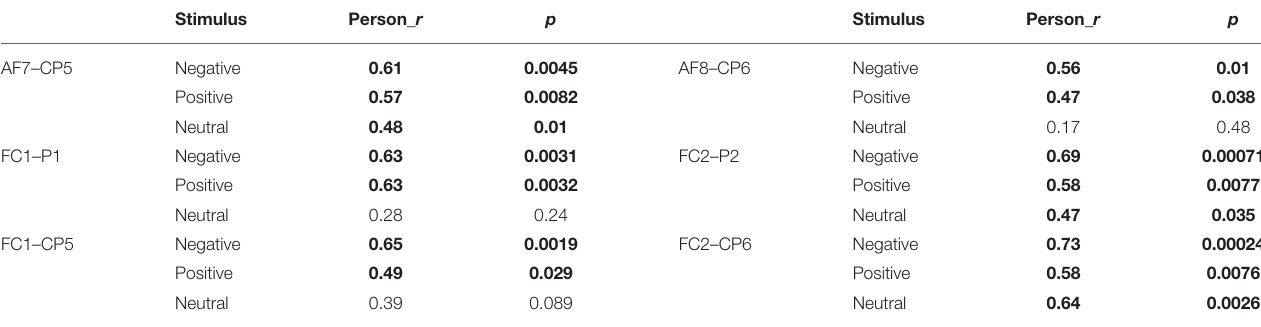
TABLE 2 | Correlations between frontoparietal alpha event-related phase coherence with prolactin in prolactinomas. Stimulus Person_ r p Stimulus Person_ r